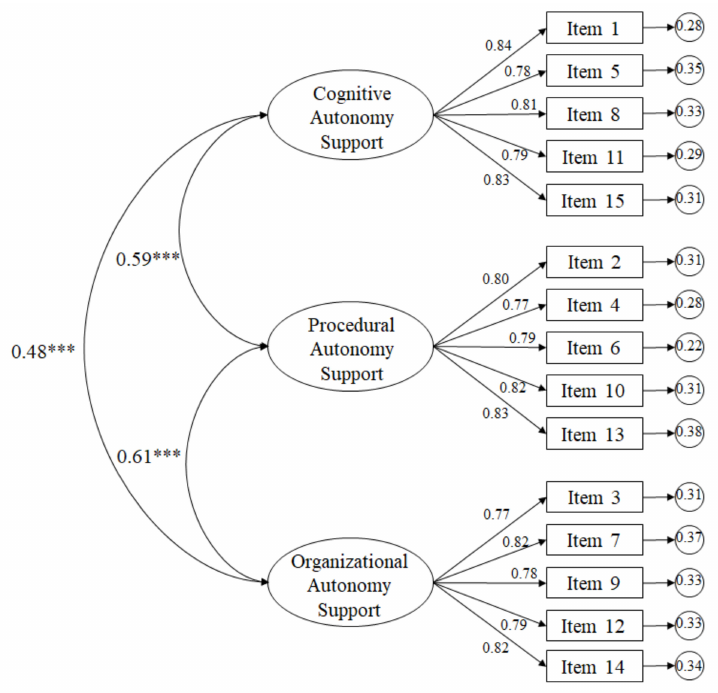
Figure 1. Confirmatory factor analysis of the tested model. *** p < 0.001.